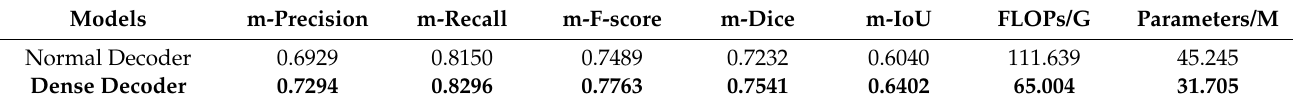
Table 4. Results of different decoder modules. The best average scores are in